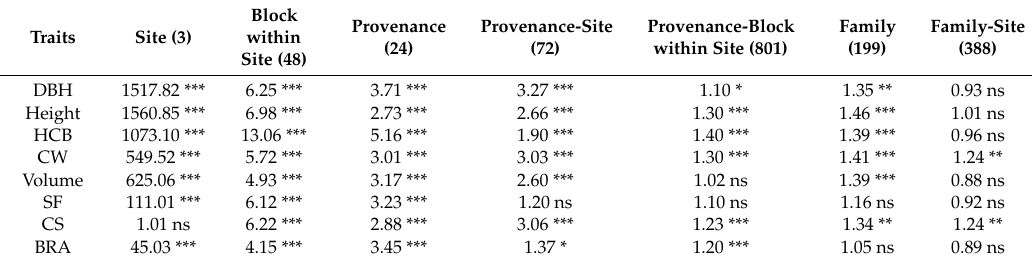
Table 5. F values and significance levels for variance from di ff erent sources of all traits in combined variance analysis of four sites.